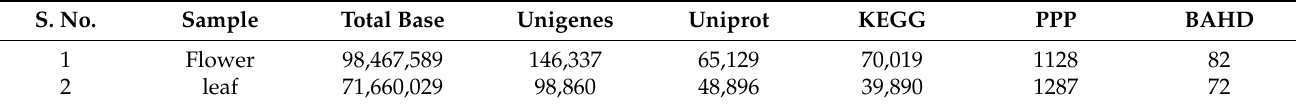
Table 1. The statistical comparisons of flower and leaf of A. spathulifolius to the annotation of unigenes. S. No.